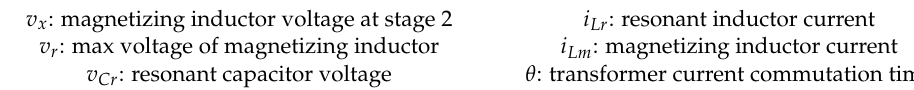
Figure 12. Waveform of six variables. Table 2. Describe of six variables.